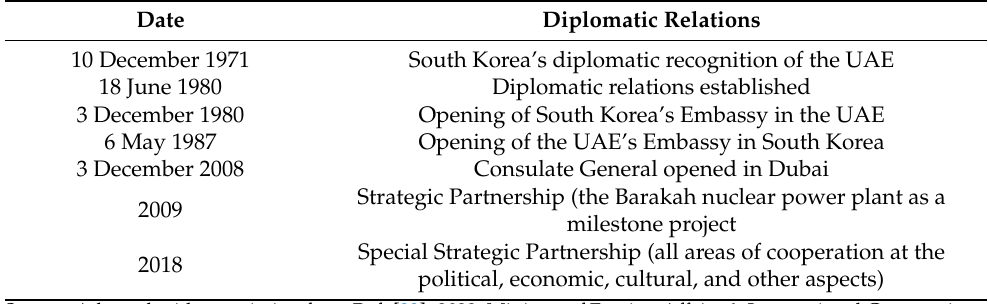
Table 1. Chronology: establishment of diplomatic relations.